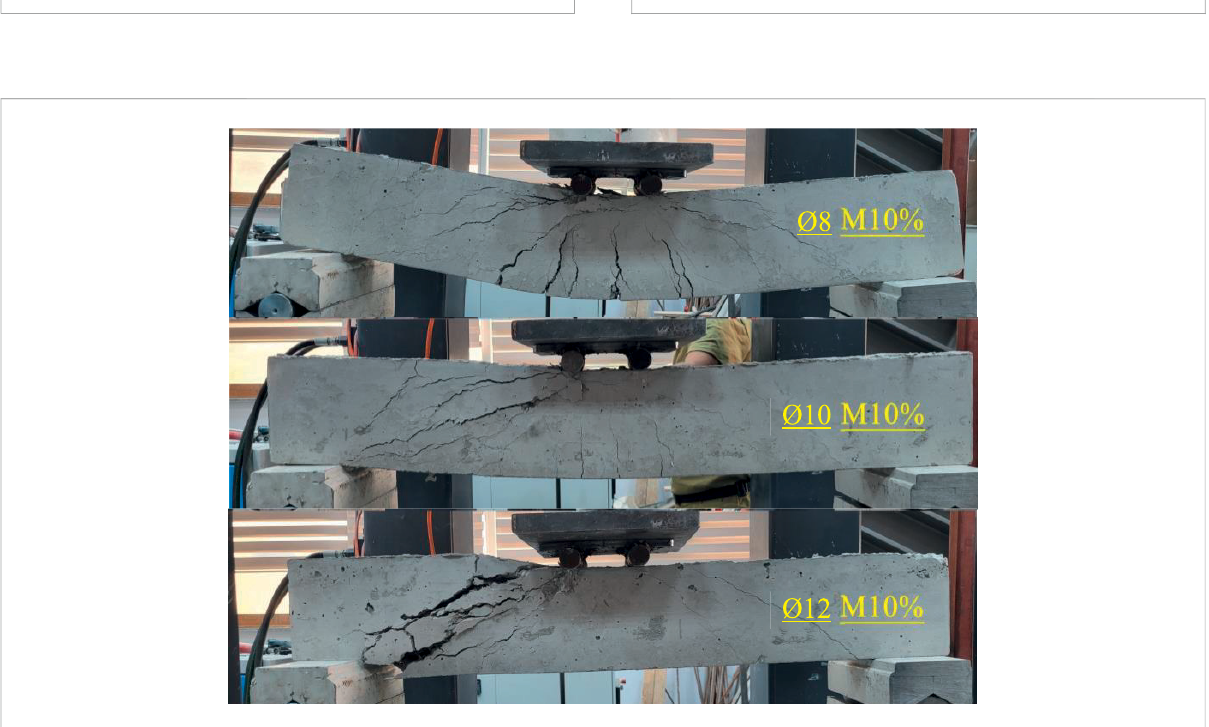
FIGURE 6 Fracture and bending attitude of RCB for V 8-M10%, V 10-M10%, V 12-M10%.